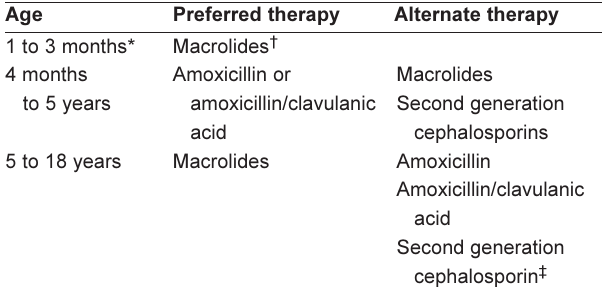
TABLE 2 Empirical antimicrobial therapy for outpatient pediatric pneumonia by age group